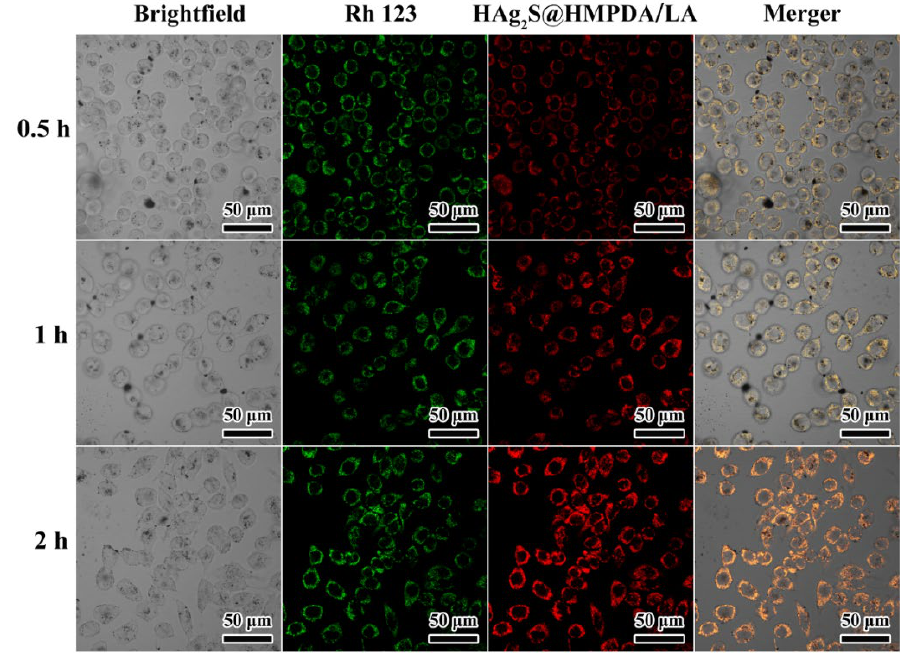
Figure 12. CLSM of HepG2 cells’ incubation with HAg 2 S@HMPDA/LA for 0.5, 1, and 2 h.